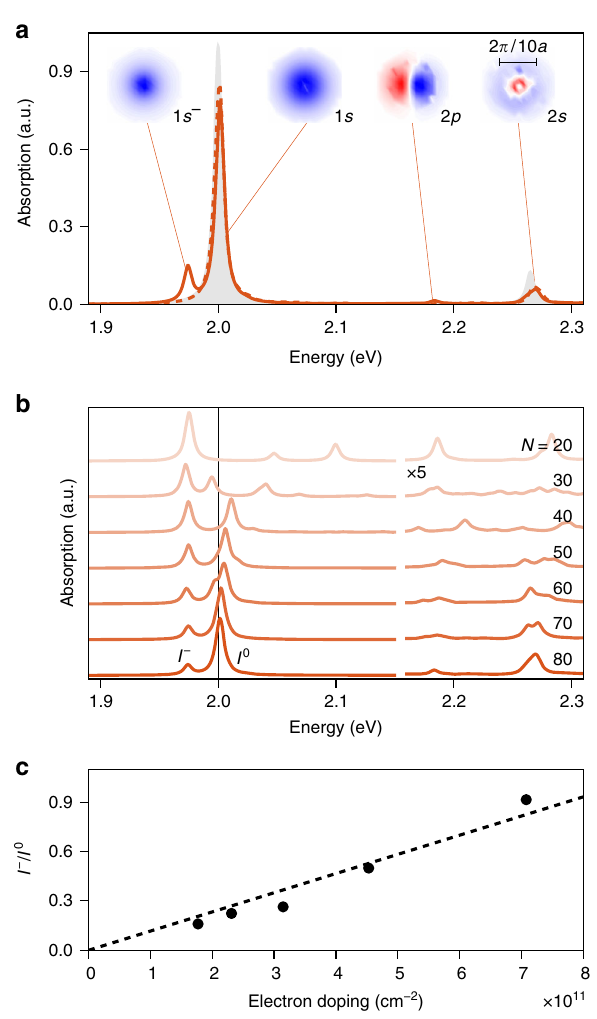
Fig. 2 Exciton and trion absorption spectra and doping dependence. a Calculated helicity-selective singlet (solid curve) and triplet (dashed curve) trion spectra of monolayer MoS 2 . The two-particle exciton spectrum is shown in gray. For select singlet trion states, the wavefunction in reciprocal space near the K point is shown as a heatmap. b Singlet trion spectra for varying Brillouin zone sampling resolutions, N . Vertical line at 2.0eV depicts the converged exciton resonance energy. Trion and exciton resonance peak are labelled as I − and I 0 , respectively. c Trion-to-exciton peak intensity ratio as a function of the electron doping density, calculated as 2 = lattice constant given by a = 3.193Å for MoS 2 (results are shown for N ≥ 40). Linear fi t with intercept at the origin shown as